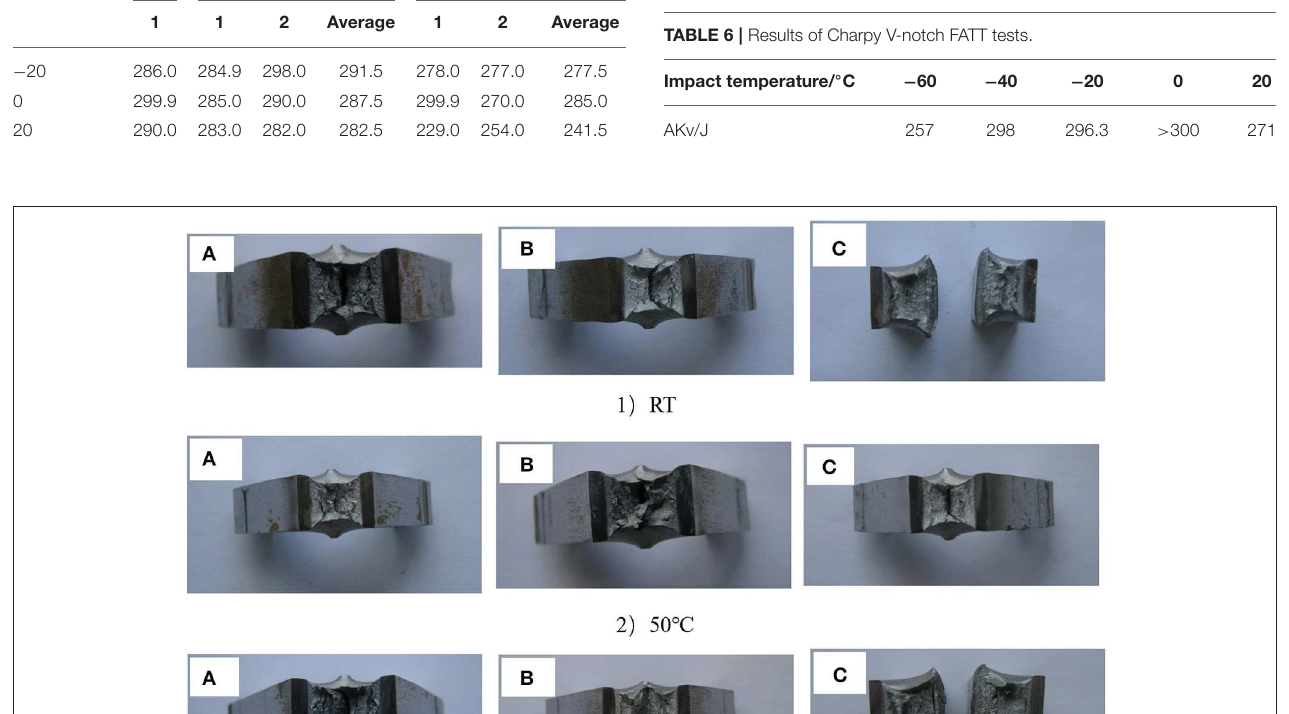
Frontiers in Materials |